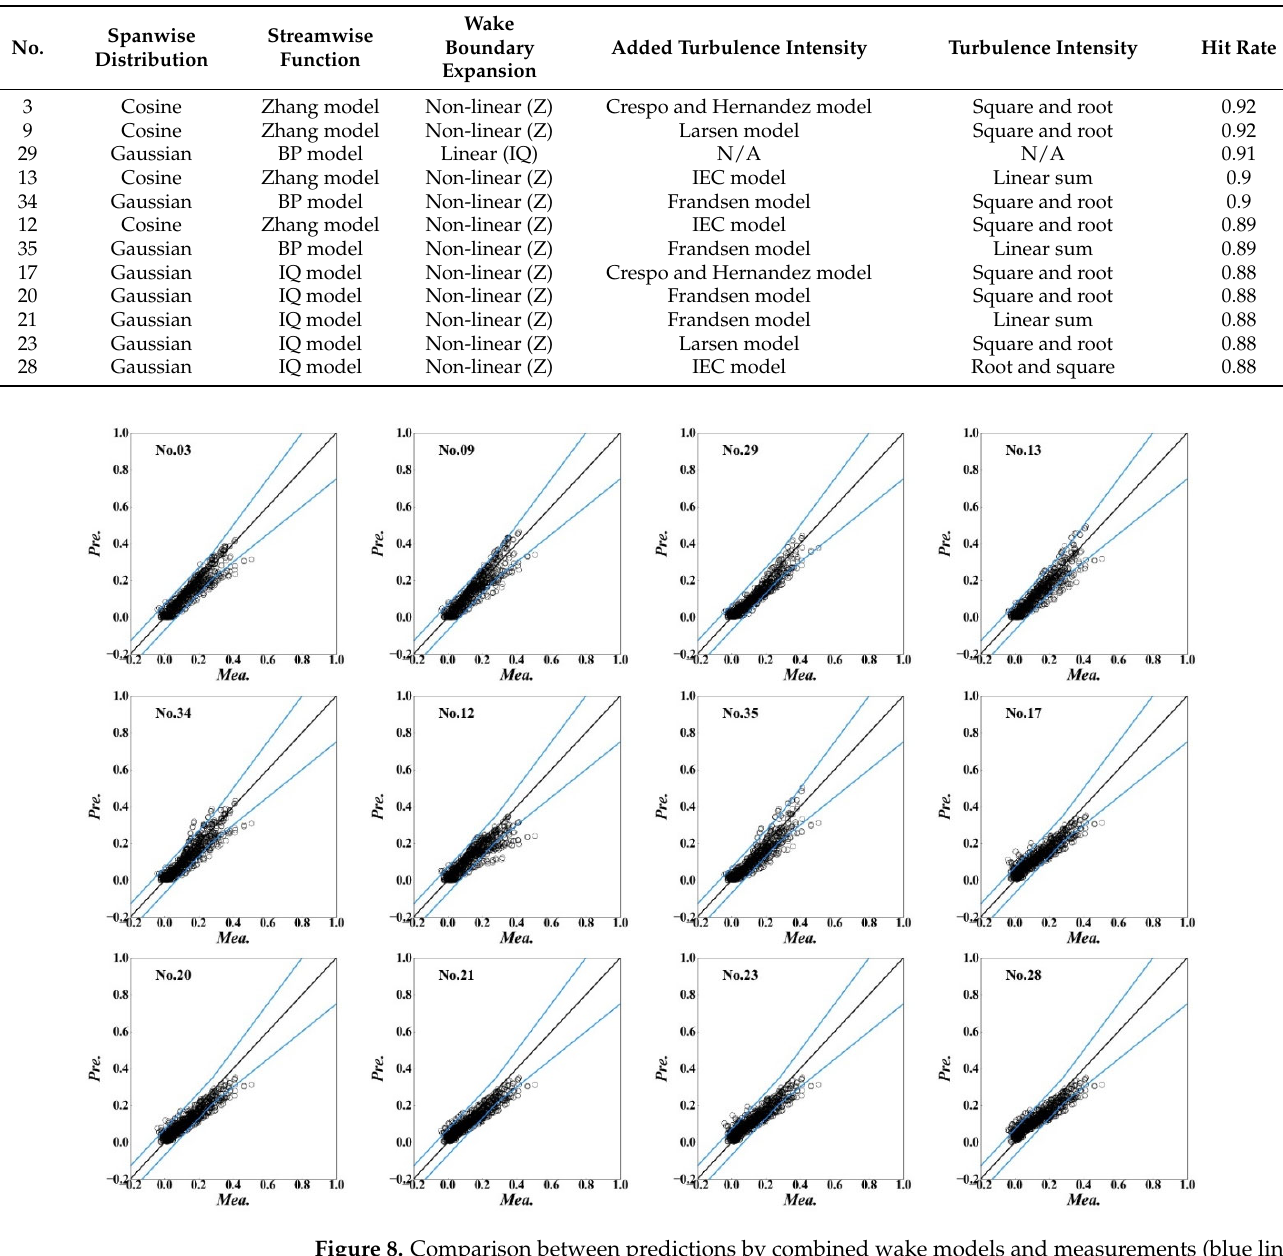
Table 8. Combined wake models with top 12 hit rates.